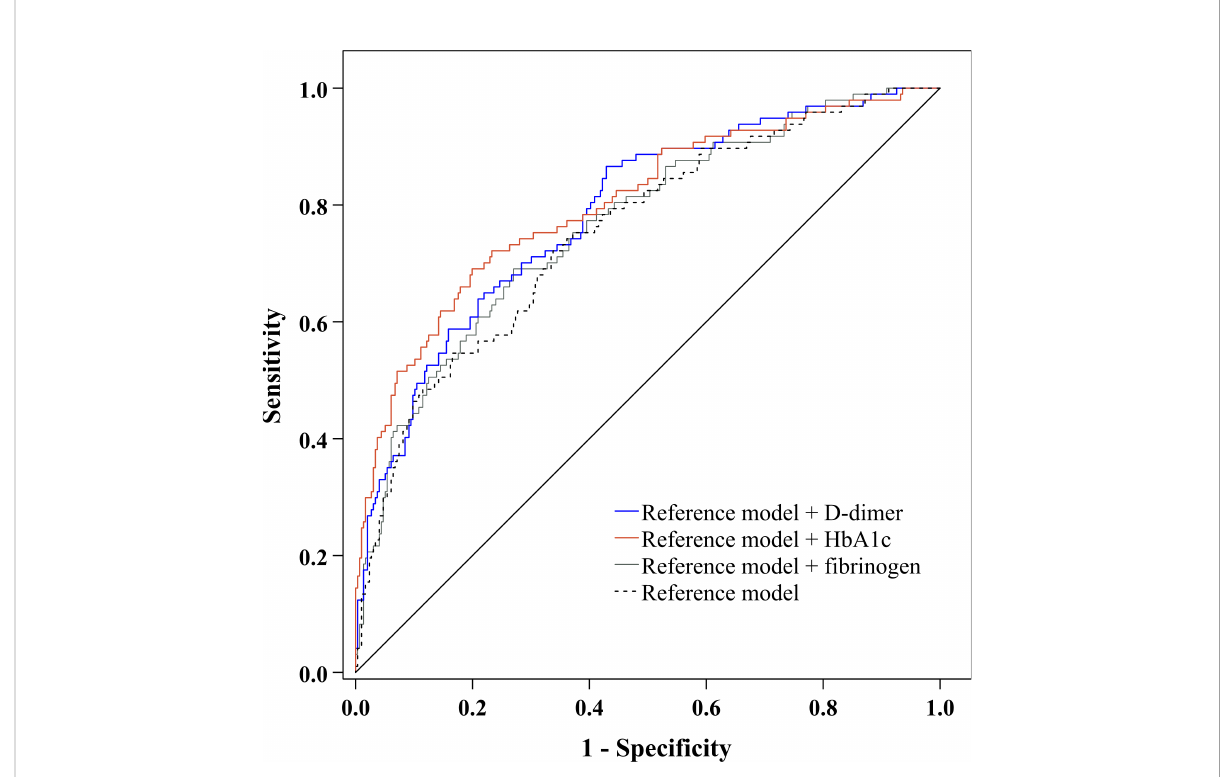
FIGURE 5 ROC curve exhibited the performance of plasma D-dimer to discriminate DPN after adjustment for traditional risk factors.